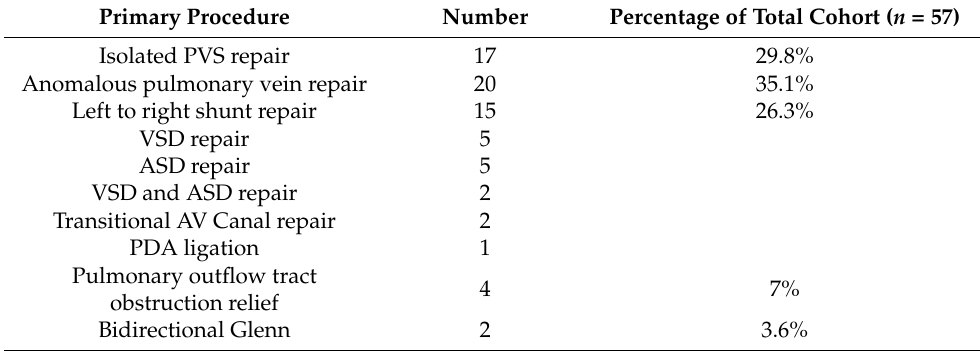
Figure 3. CT scans from the above described patient from Vietnam with left common pulmonary vein stenosis. The left image is a 3D reconstruction of a CT angiogram with the view of the left pulmonary vein connection to the left atrium. The arrow denotes the area of stenosis. The right image is a traditional CT angiogram with sternum anterior and spine posterior. The green marker is of the stenosis which narrows to 2.58 mm. The blue marker is of the length of the area of stenosis which is 4.42 mm. Table 3. General cardiac surgery categories. One patient who underwent TAPVR repair also had a Glenn. Nearly one-third of patients had isolated PVS repair and slightly more than a third had anomalous pulmonary venous repair. Left to right shunts were commonly repaired. Note, some cases of anomalous pulmonary vein repairs may have had left to right shunts (i.e., ASDs) that were repaired, but not noted in the